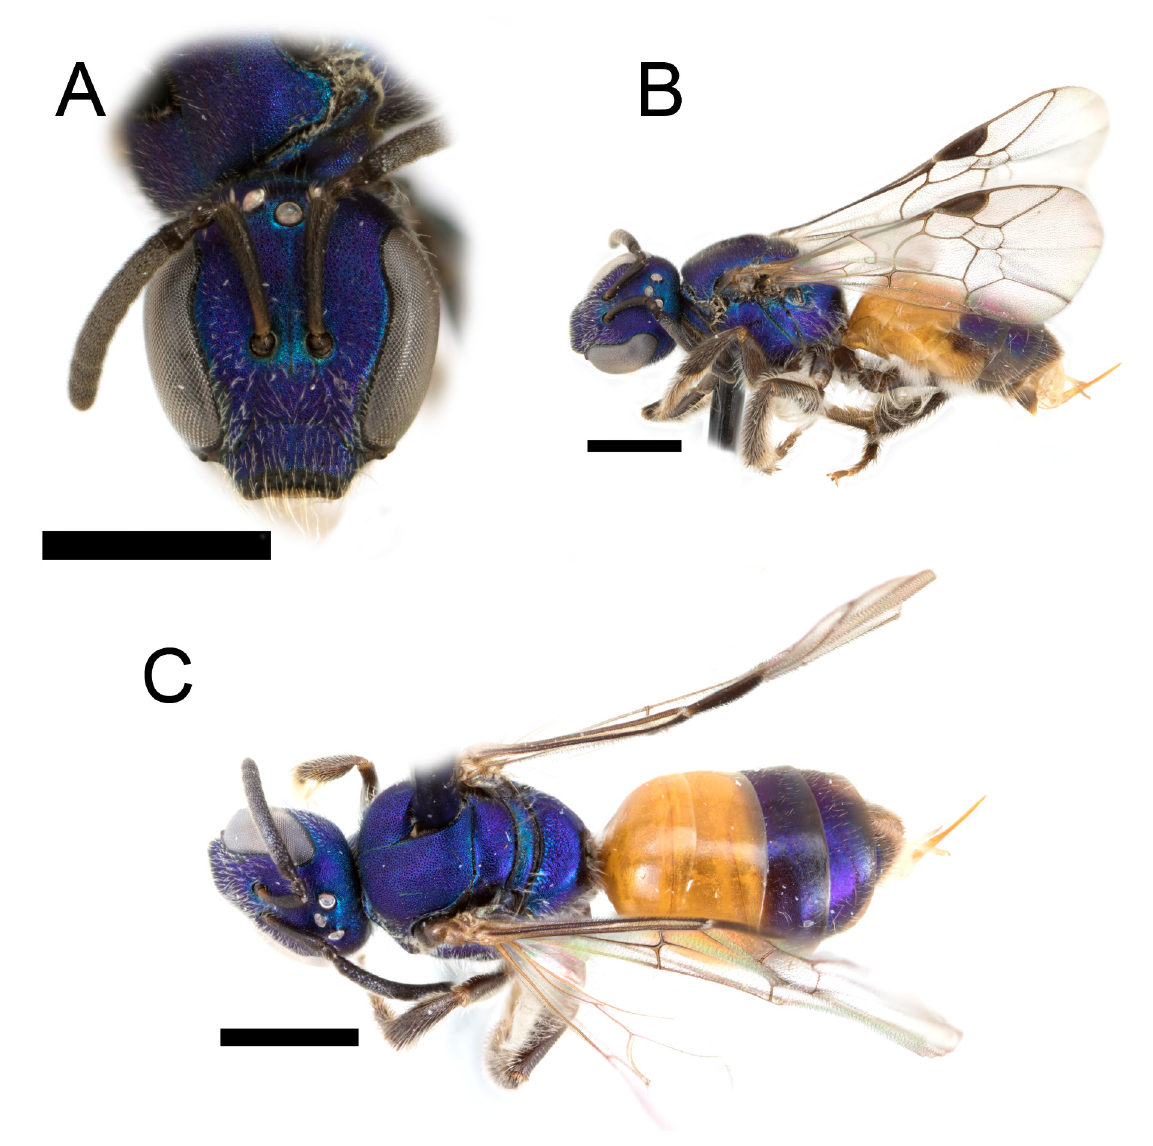
Fig. 24. Lasioglossum eickwortellum (Engel, 2001), ♀. A . Face. B . Lateral habitus. C . Dorsal habitus. Scale bars = 1